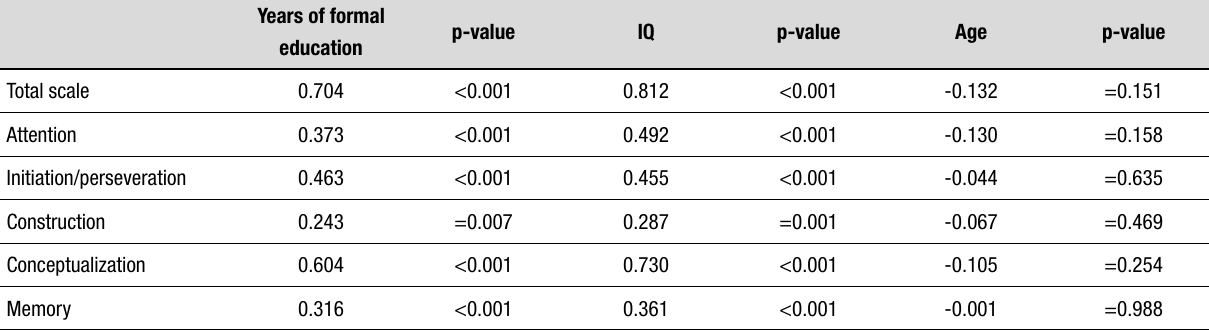
) for years of formal education, intelligence quotient, and s